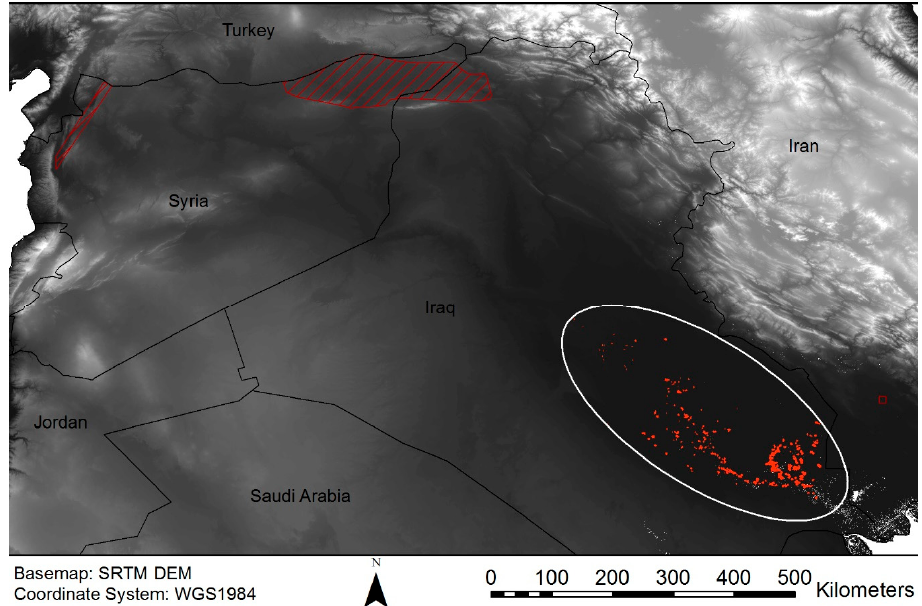
Figure 1. The locations of hollow ways documented in the Near East, including the new hollow ways presented in this paper, circled in white.